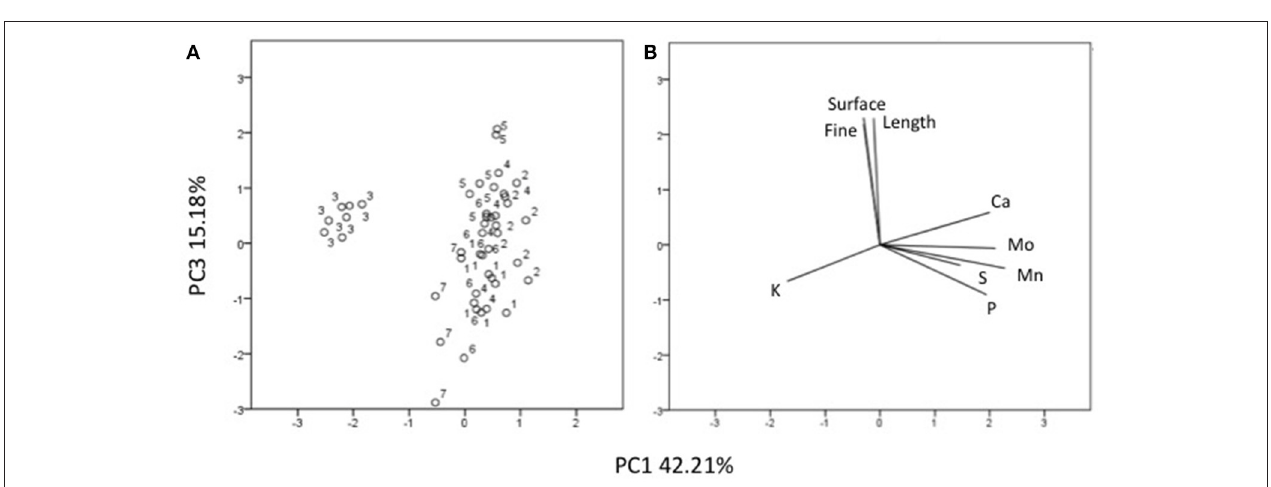
FIGURE 5 | Position of the samples representative of maize plants untreated and treated with seaweed extracts (A) and of the variables (B) projected in the plane determined by the first two principal axes of the PCA. Seaweed extracts correspond to the circle number A = 1, B = 2, C = 3, D = 4, E = 5, F = 6, and untreated plants = 7. EstL and EstR: esterase activity in leaves and in roots, respectively.